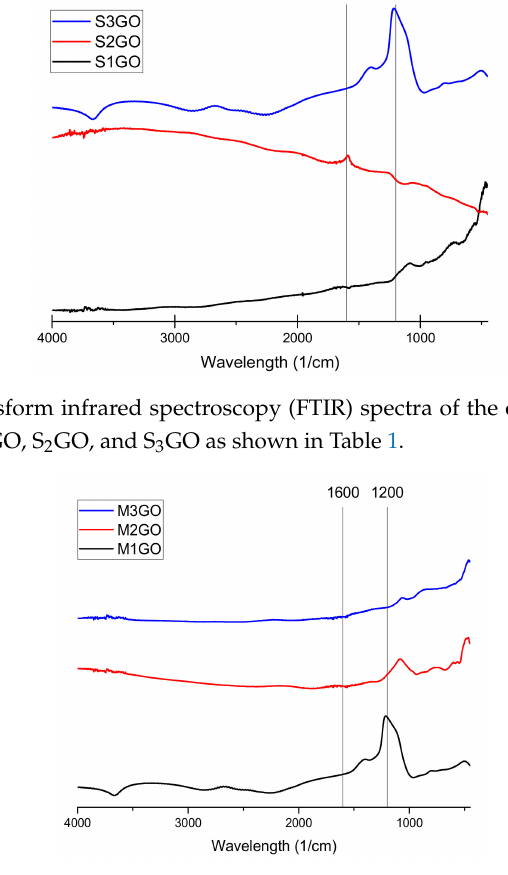
Figure 3. FTIR spectra of the examined graphene oxide powder of samples M 1 GO, M 2 GO, and M 3 GO as shown in Table 1.